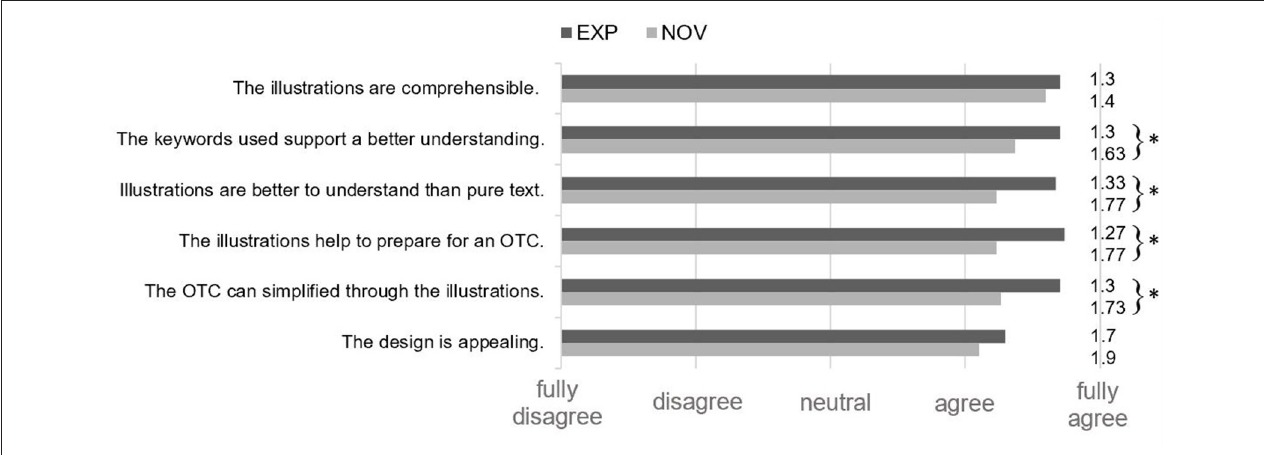
FIGURE 2 | Presentation of the results of assessment of the characteristics by the patients of the illustrations using the Likert Scale (1 - fully agree to 5 - fully disagree) (EXP n = 30, NOW n = 30) ( p < 0.05). *Significant differences were demonstrated for these results.